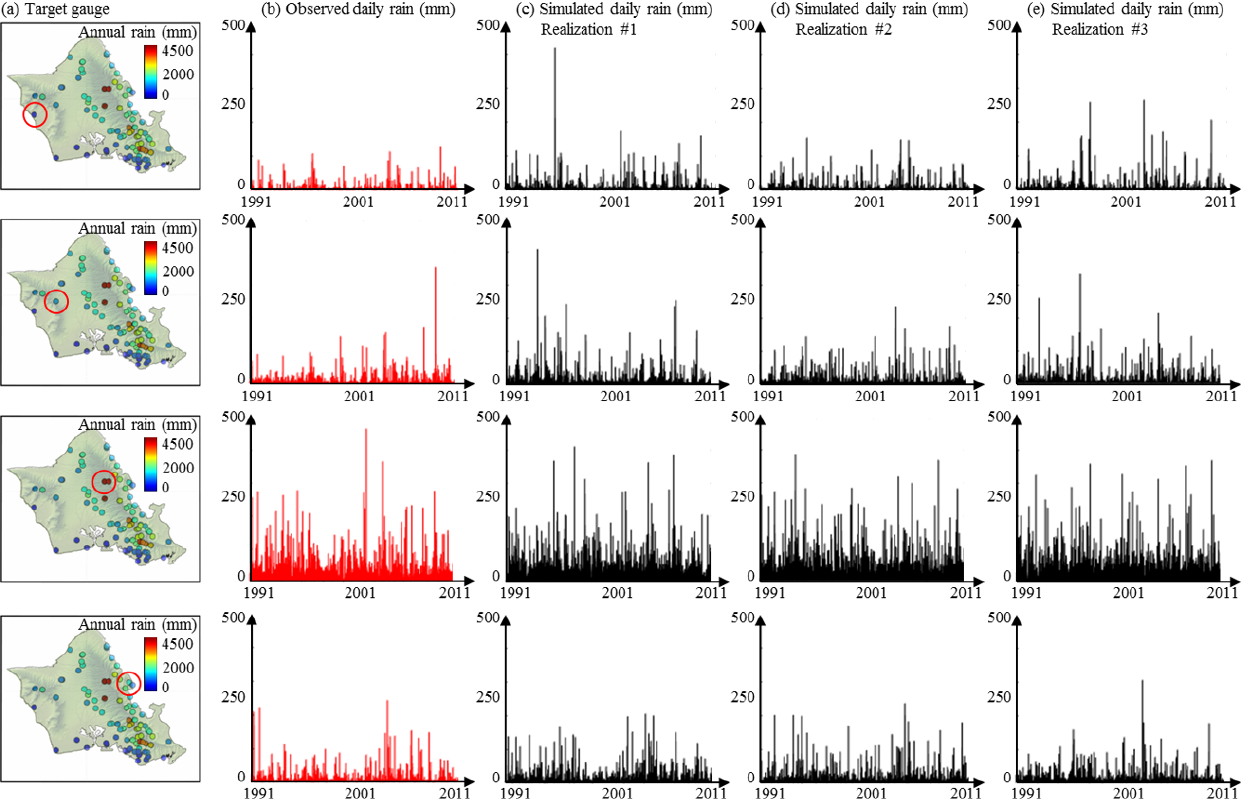
Figure 4. Ability of the model to simulate realistic rainfall time series on O‘ahu. (a) Target locations. (b) Observed rainfall time series for the period 1991–2011. (c–e) Simulated time series. For readability, only the three first realizations of the 50-member ensemble are